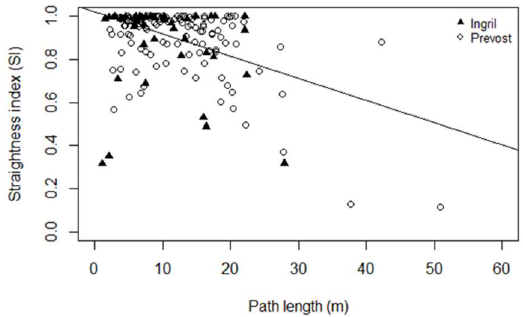
Figure 3. Relationship between the net to gross displacement ratio ‘straightness index’ and the fish school path length (Full triangles: the Ingril lagoon. Empty circles: the Prévost lagoon). The black line represents the single significant linear relationship found for the Prévost lagoon.